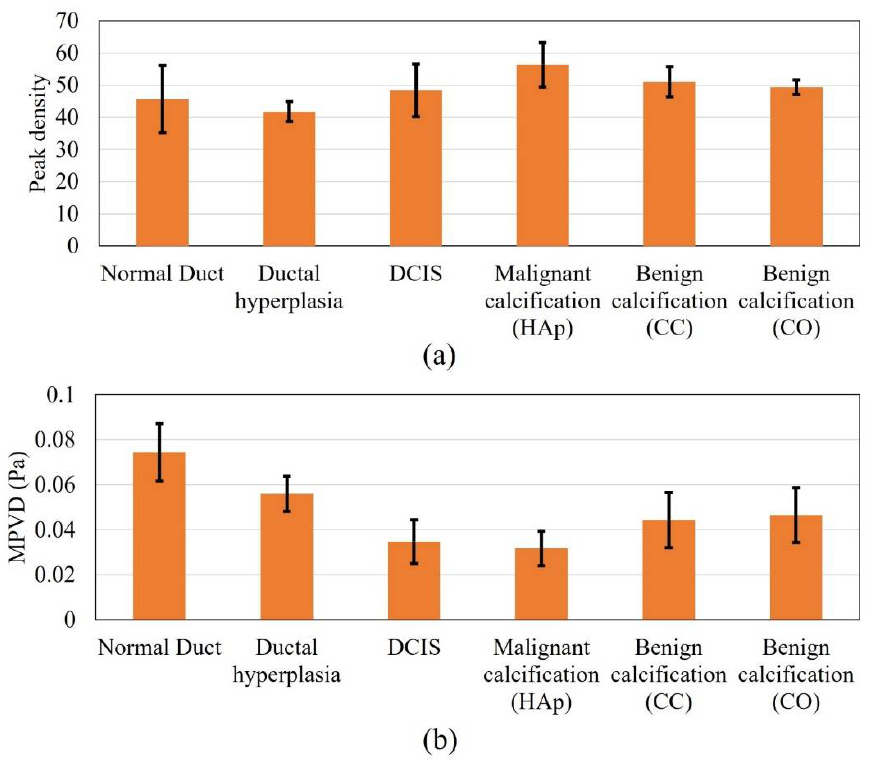
Figure 5. Response values for all the models in pulse-echo mode, ( a ) peak density and ( b )